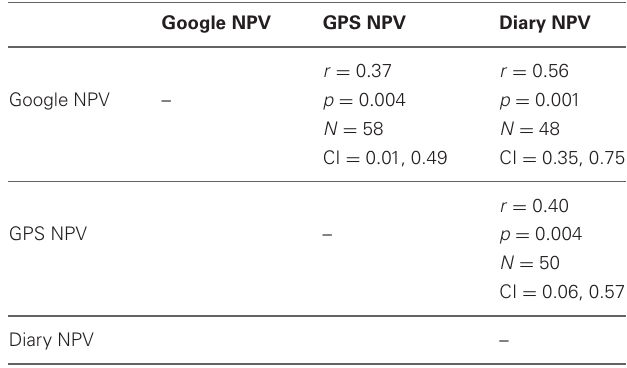
Table 3 | Correlations among NPV variables.